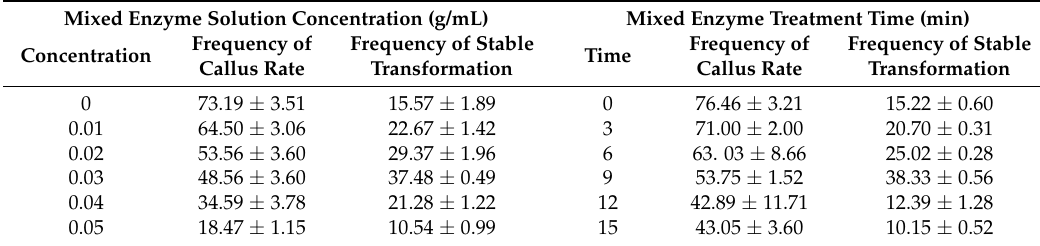
Table 3. Effect of pretreatment conditions on egfp